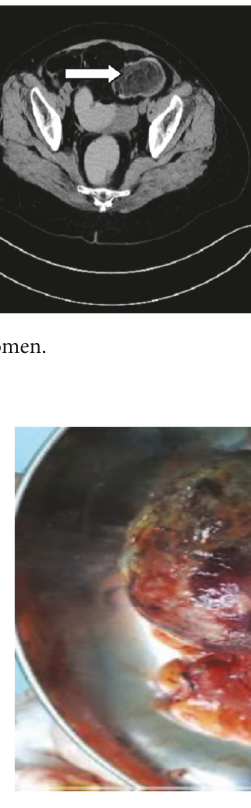
Figure 3: Gross surgical section of